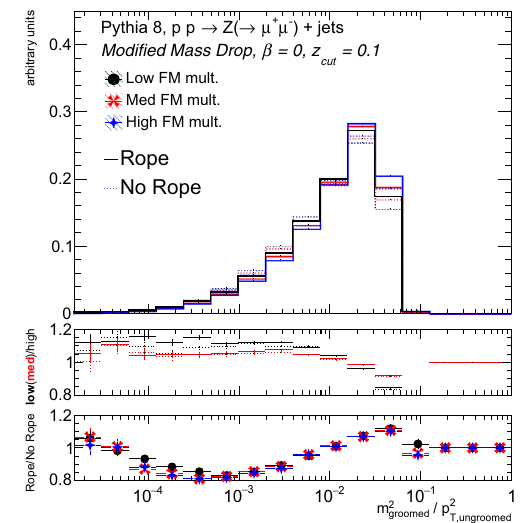
Fig. 11 Modified Mass Drop (also Soft Drop with β = 0) jet mass (left) and momentum sharing z g (right) for three bins in FM that corre- spond to the 50th, 75, and 90th percentiles. The middle panel shows the ratio of the distributions for high to low multiplicity for both hadroniza- tion models (standard hadronization with a dotted line). In the lower